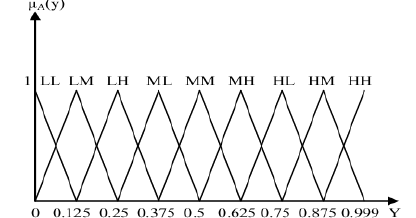
Figure 4 . Assess fuzzy result